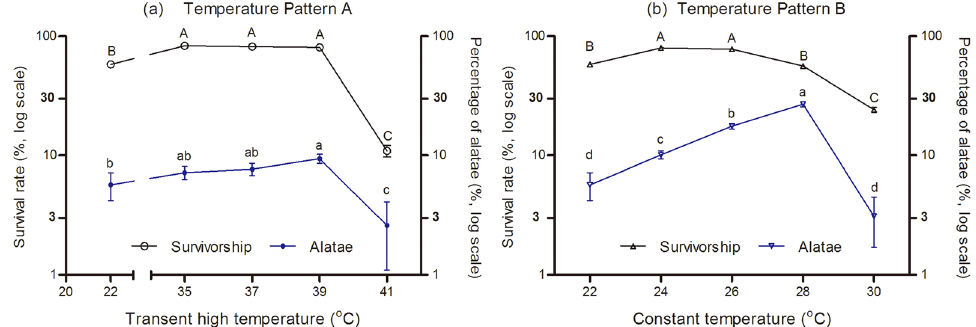
Figure 4. Survivorship and alatae induction (mean ± SE%) of Rhopalosiphum maidis at two temperature patterns: ( a ) Temperature pattern A; ( b ) Temperature pattern B. Different capital or lowercase letters represent significant differences ( P < 0.05) by using Tukey’s multiple range tests.